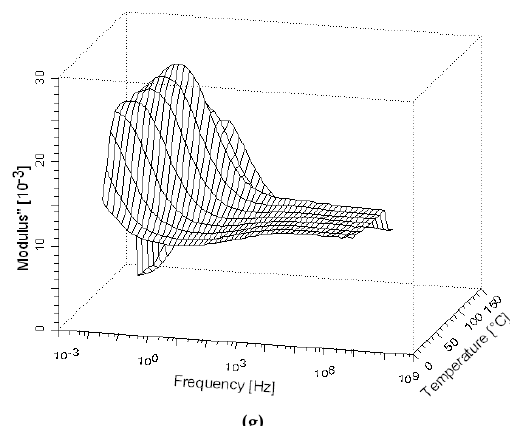
Figure 9. Three-dimensional diagrams of the imaginary component of the electric module (M”) in relation to temperature and frequency for LLDPE ( a ), LLDPE / GTR-5% ( b ), LLDPE / GTR-10% ( c ), LLDPE / GTR-20% ( d ), LLDPE / GTR-40% ( e ), LLDPE / GTR-50% ( f ), LLDPE / GTR-70% ( g ).